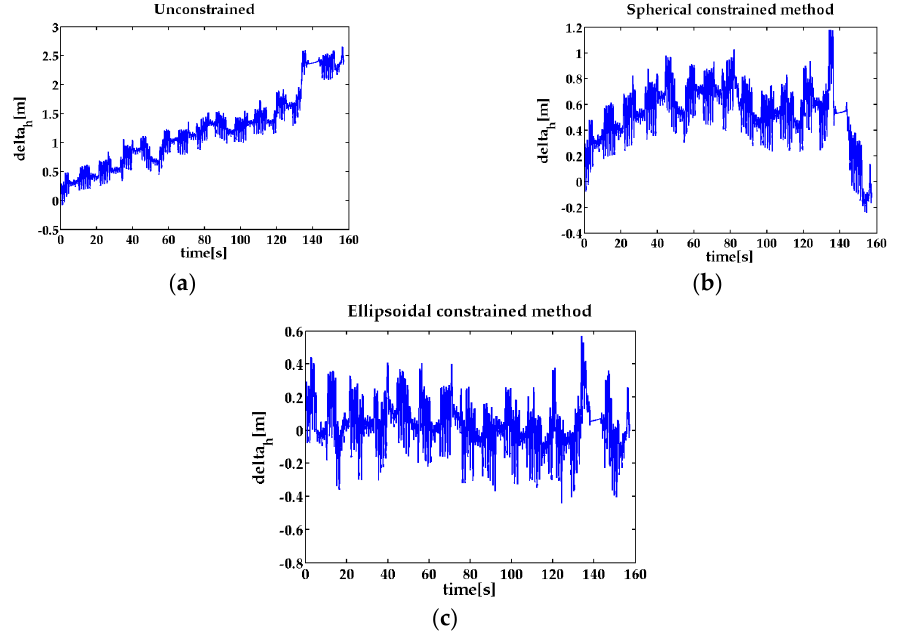
Figure 7. The left and right feet position altitude difference in the upstairs experiment. ( a ) the height difference of the two feet without constraint; ( b ) the height difference of the two feet with spherical constraint; ( c ) the height difference of the two feet with ellipsoidal constraint.